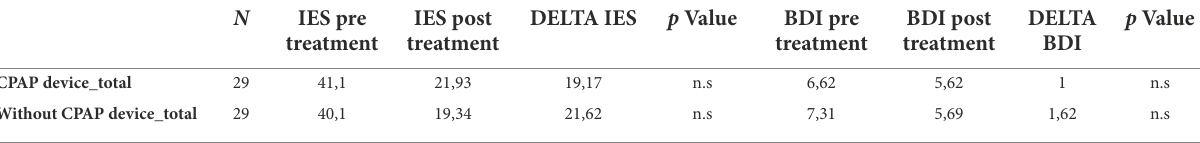
TABLE 3 Averages values of IES-R and BDI scores of patients stratified for the use of CPAP device during hospitalization and EMDR treatment during psychological